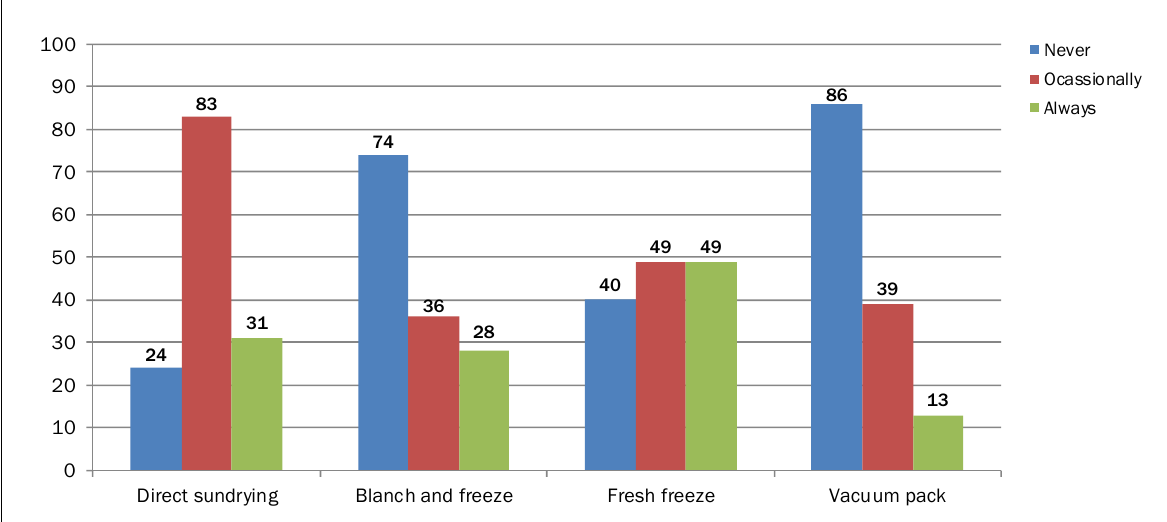
Figure 2. How Often Would You Buy Value-Added Cowpea Leaves? (count; N